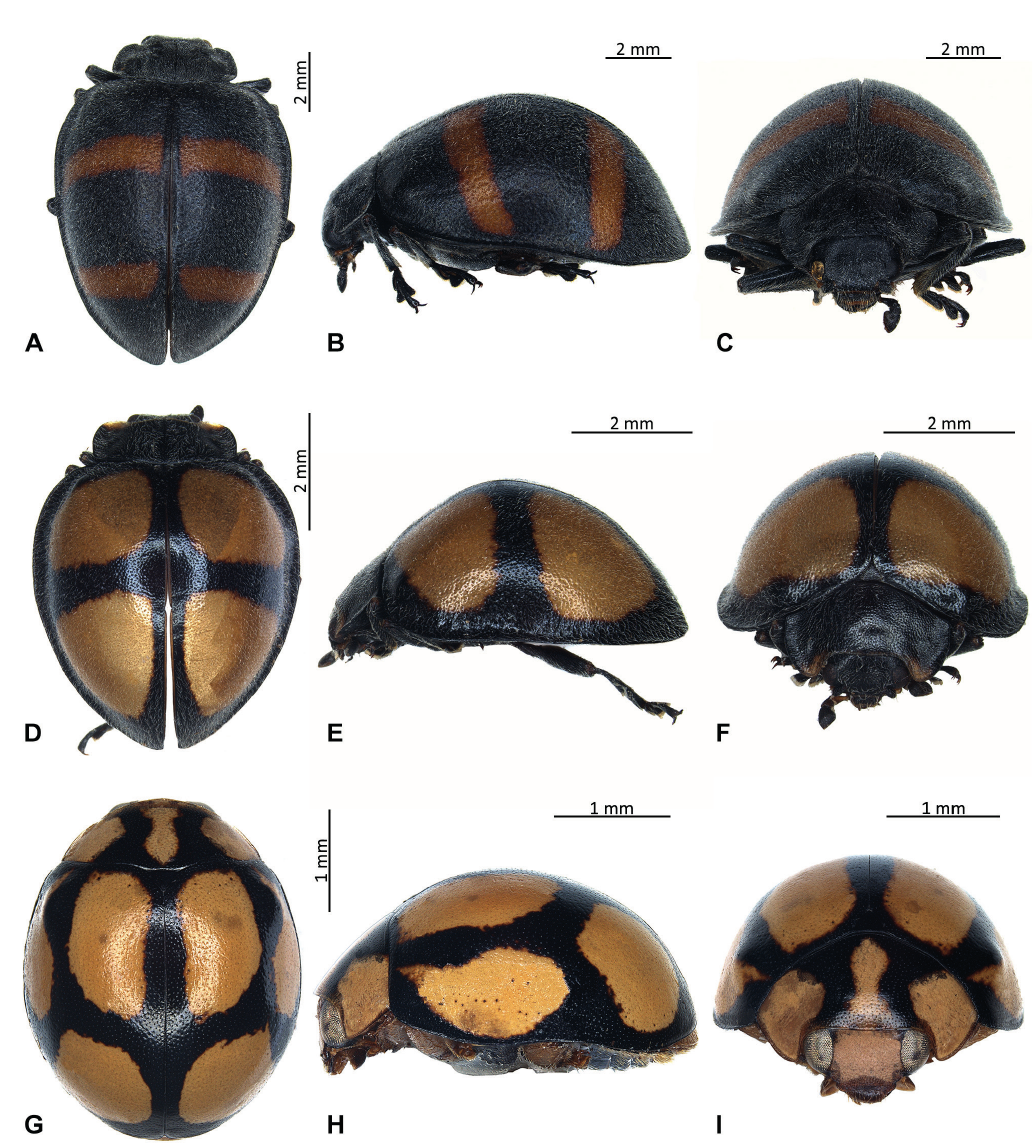
Fig. 10. Habitus. A–C . Epilachna obtusiforma Gordon, 1975, ♀ (MIZ). A . Dorsal view. B . Lateral view. C . Frontal view. D–F . Toxotoma gonzalezi sp. nov., ♂, holotype (MNHW). D . Dorsal view. E . Lateral view. F . Frontal view. G–I . Hyperaspis rutai sp. nov., ♂, holotype (MNHW). G . Dorsal view. H . Lateral view. I . Frontal